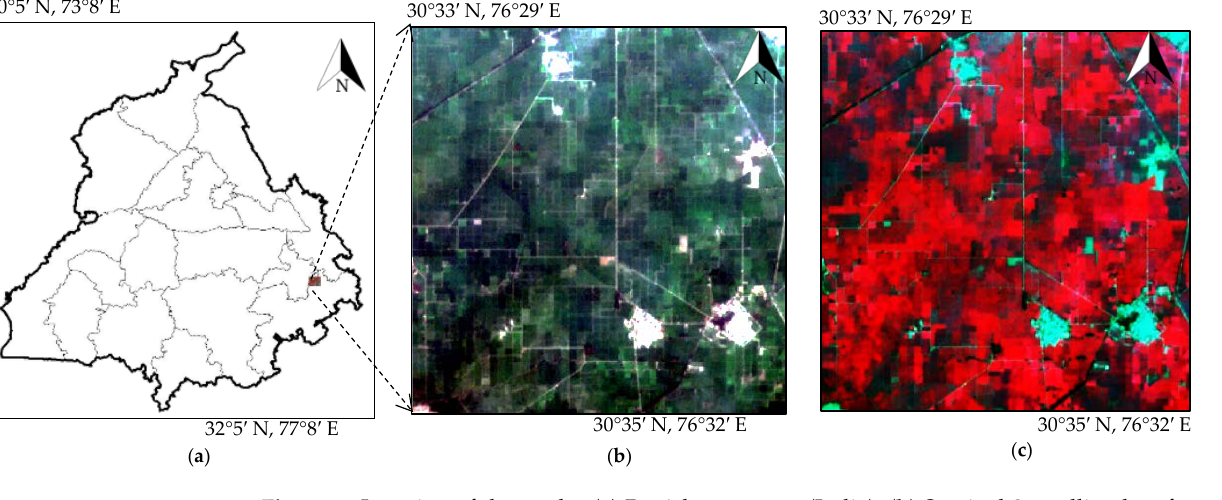
Figure 1. Location of the study: ( a ) Punjab state map (India), ( b ) Sentinel-2 satellite data from 19 February 2018 in Red-Green-Blue 4-3-2 color bands (for the natural color), ( c ) Color infrared imagery from 19 February 2018 in Red-Green-Blue 8-4-3 color bands (color infrared highlighting the unhealthy and healthy